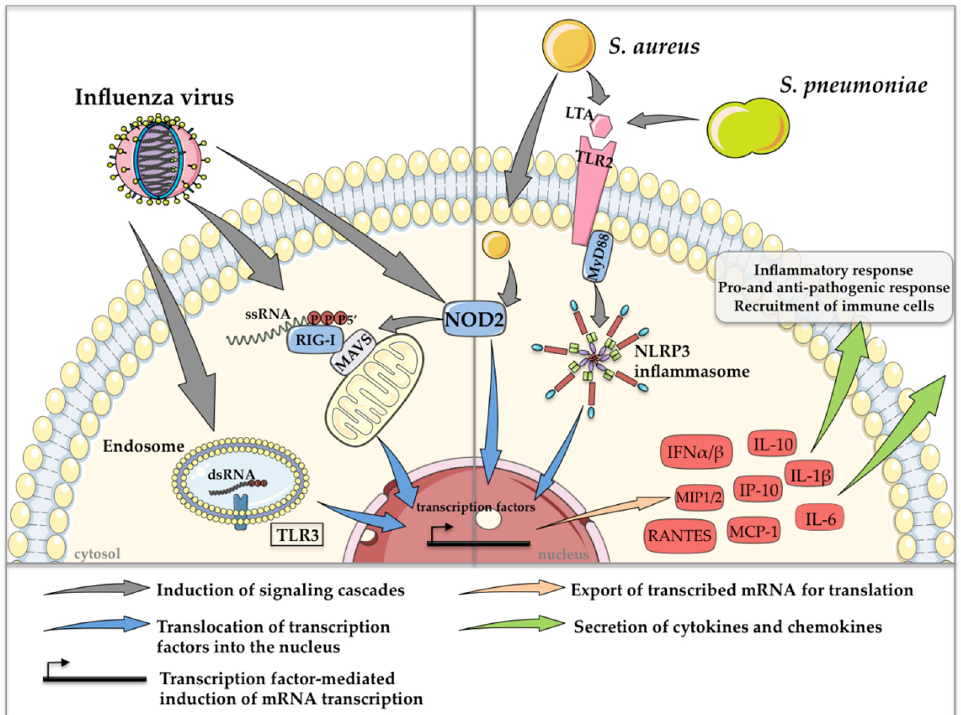
Figure 2. Schematic depiction of the most prominent PRR-mediated signaling events in co-infections with influenza viruses and S. pneumoniae or S. aureus . Detection of extra- and intracellular PAMPs induces the expression of type I IFN and various cytokines and chemokines, resulting in pro- and anti-pathogen responses and the recruitment of immune cells. This figure was created using Servier Medical Art templates, which are licensed under a Creative Commons Attribution 3.0 Unported License; https://smart.servier.com (accessed on 11 February